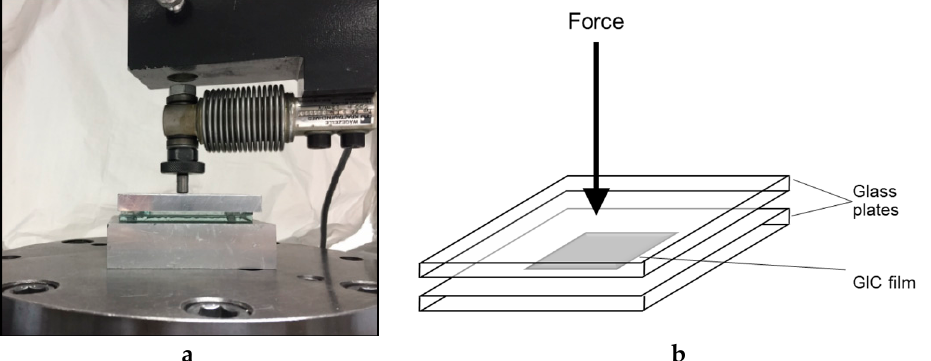
Figure 7. ( a ) Loading of two glass plates with film thickness specimen in between; ( b ) Schematic diagram showing film thickness testing.